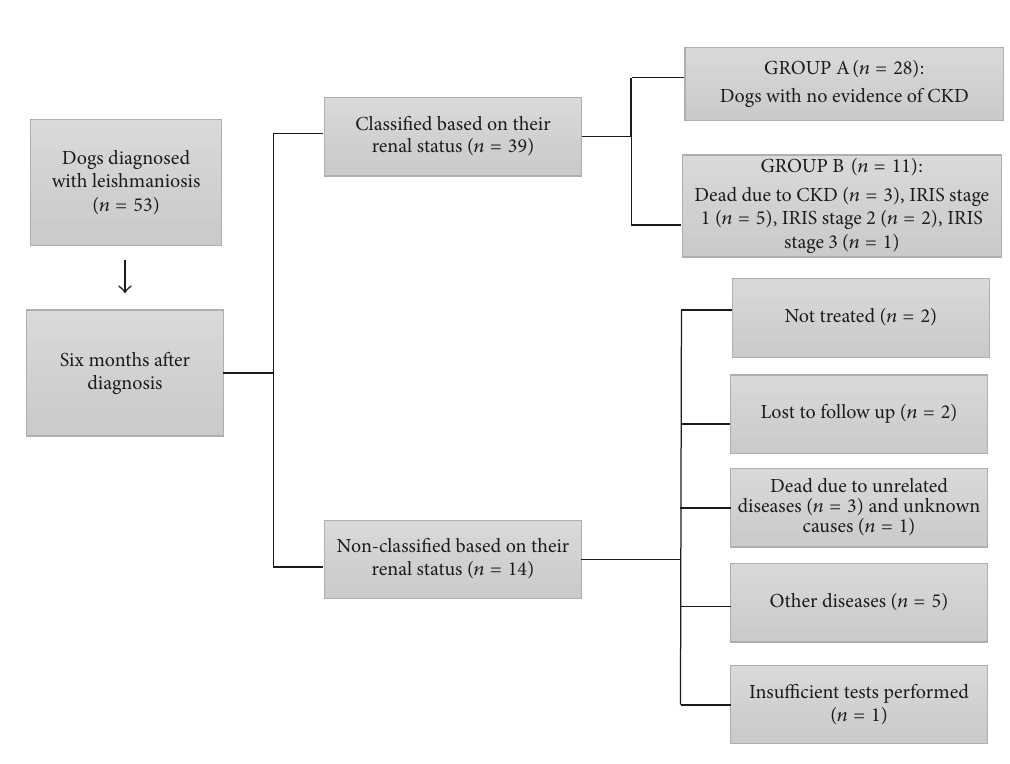
Figure 4: Flowchart depicting the clinical and renal outcome of 53 dogs with clinical leishmaniosis six months after diagnosis and their classification into two groups according to the presence of CKD. Group A: dogs with no evidence of CKD six months after diagnosis. Group B: dogs with CKD disease after six months of diagnosis or dogs that died due to renal disease during this period. Classification of IRIS stage was done following the IRIS guidelines for staging CKD [25] as detailed in Figure 1. IRIS: International Renal Interest Society; CKD: chronic kidney disease. 𝑛 : number of